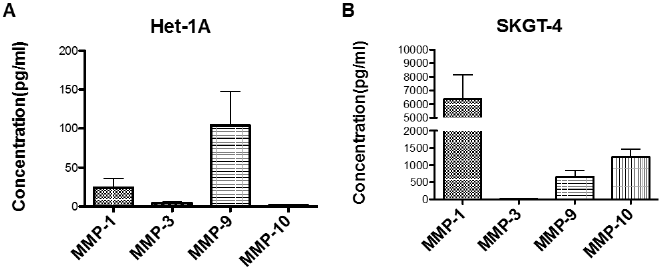
Figure 4. Basal protein expression of MMPs in oesophageal cells. Quantification of secreted levels of MMP-1, MMP-3, MMP-9 and MMP-10 in non-stimulated Het-1A cells ( A ) and non-stimulated SKGT-4 cells ( B ). n = 3 for each group .